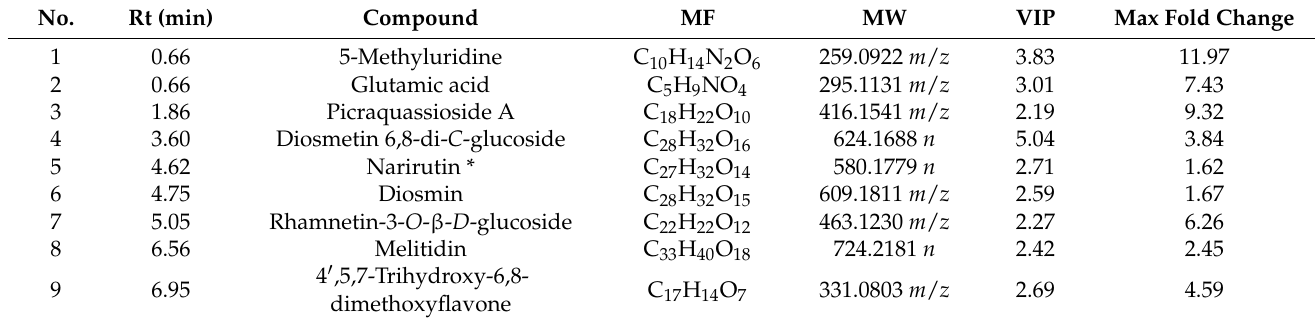
Table 3. Special differential metabolites screened from Qingpi samples stored for 1 to 5 years.